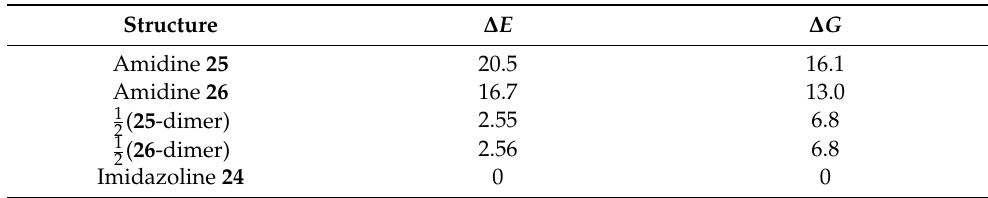
Table 1. MP2/6-311++G(d,p) relative energies ∆ E and free energies ∆ G (kcal/mol) of amidines 25 , 26 , their dimers, and imidazoline 24 .